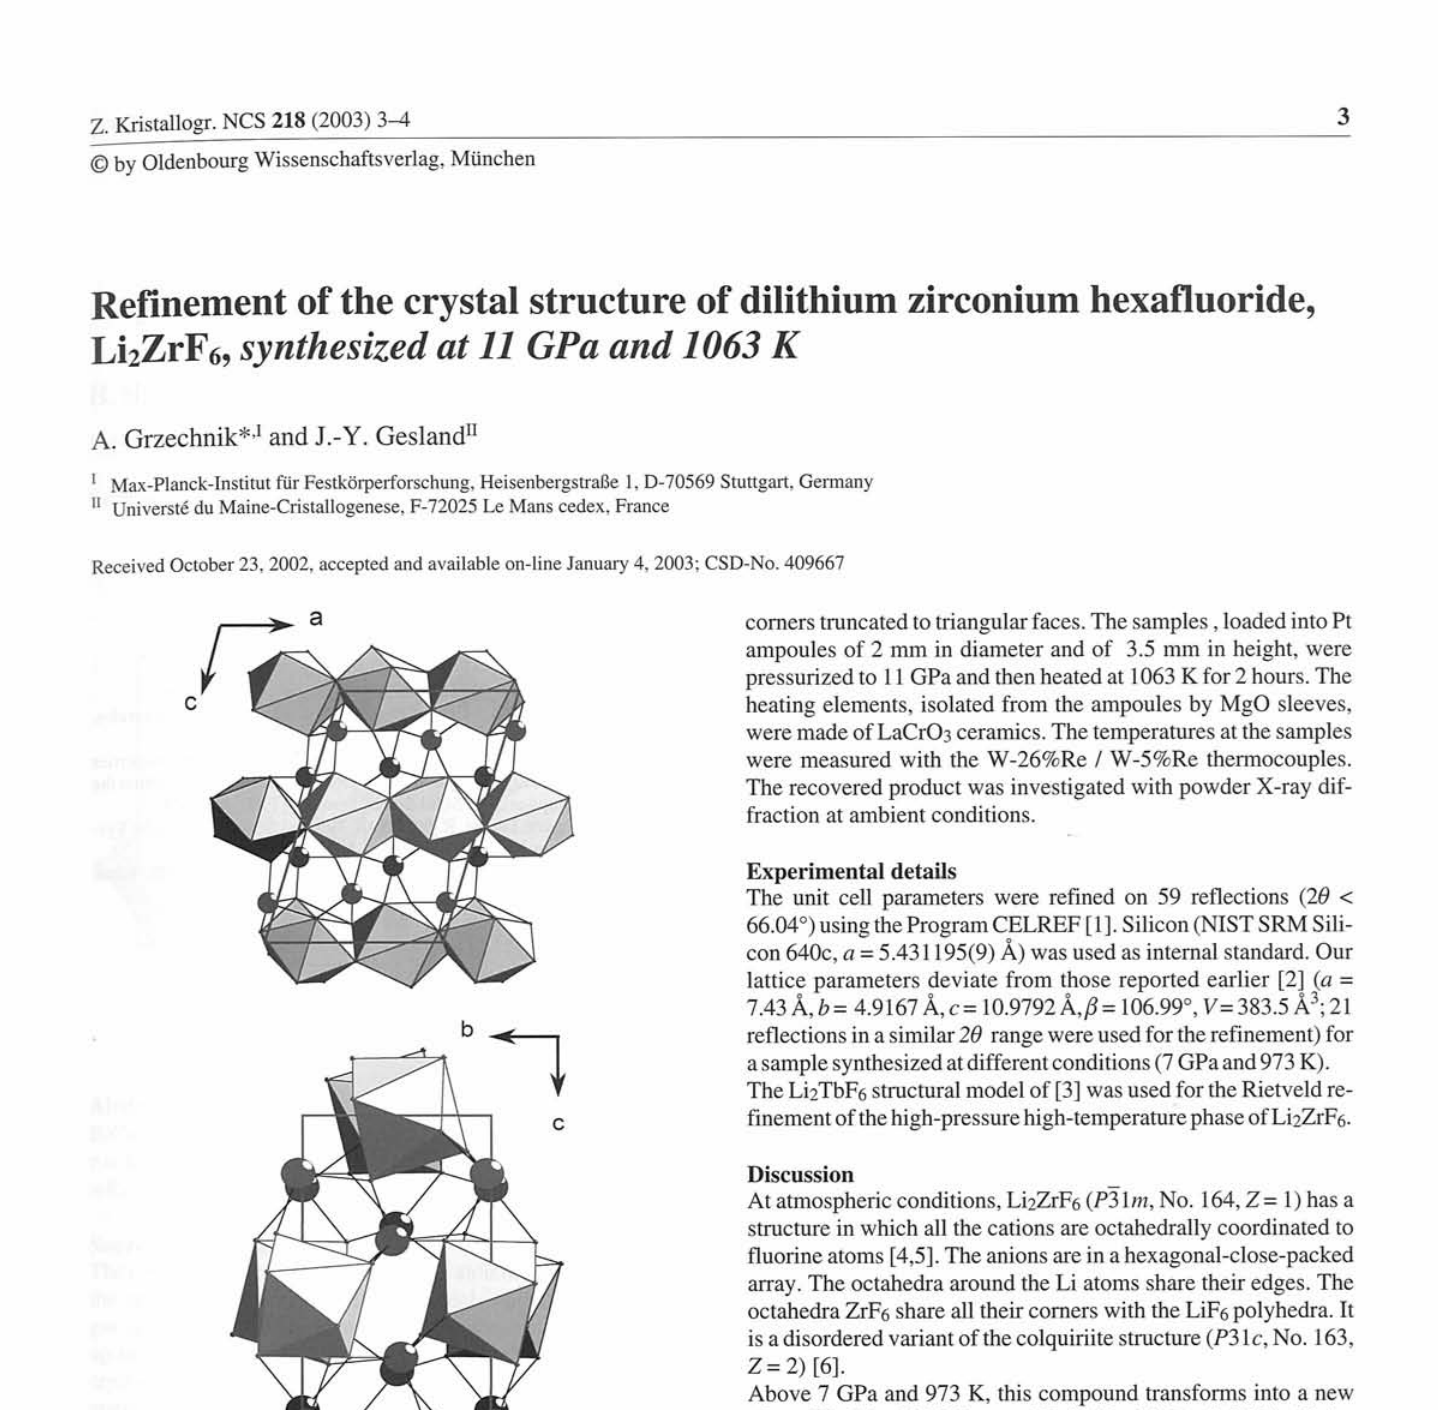
Table 1. Data collection and